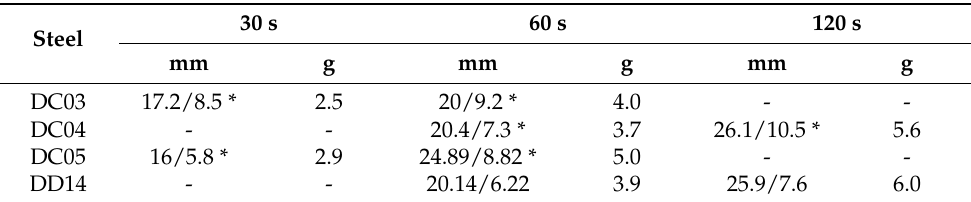
Table 8. Crater diameter (according to Figure 2) (mm)/crater depth and weight loss in (g).